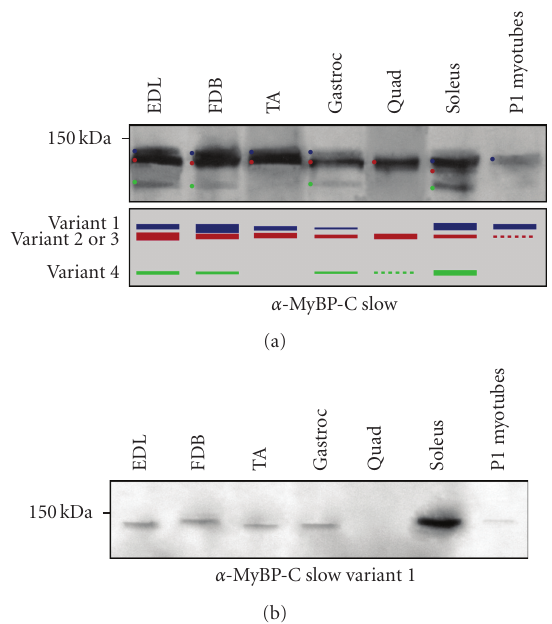
Figure 3: Western blot analysis of protein homogenates prepared from rat skeletal muscles and blotted with antibodies to the fifth Ig domain that recognize all MyBP-C slow variants (a) or to the novel COOH-terminal insertion that specifically recognizes variant 1 (b). (a) Top panel: With the exception of quadriceps, all other muscles express variant 1, represented by the upper most band, marked by a blue dot. All adult skeletal muscles tested, but not the developing myofibers, express variants 2 and/or 3, corresponding to the band with the intermediate mobility, and denoted with a red dot. As variants 2 and 3 have similar molecular weights (129 and 128 kDa, respectively), it is not feasible to separate them in the current gel system. Moreover, variant 4 is detected in homogenates prepared from EDL, FDB, gastrocnemious, and soleus, and is represented by the lower immunoreactive band, marked with a green dot. Bottom panel: A cartoon showing the presence of the di ff erent MyBP-C slow variants in developing and adult skeletal muscles. Dotted lines correspond to immunoreactive bands, which are evident only after long exposure times. (b) In agreement with the immunoblot shown in panel (a), antibodies specific for the novel COOH-terminal insert demonstrated that EDL, FDB, TA, gastrocnemious, soleus, and P1 skeletal myotubes express variant 1, with soleus containing the highest amounts.